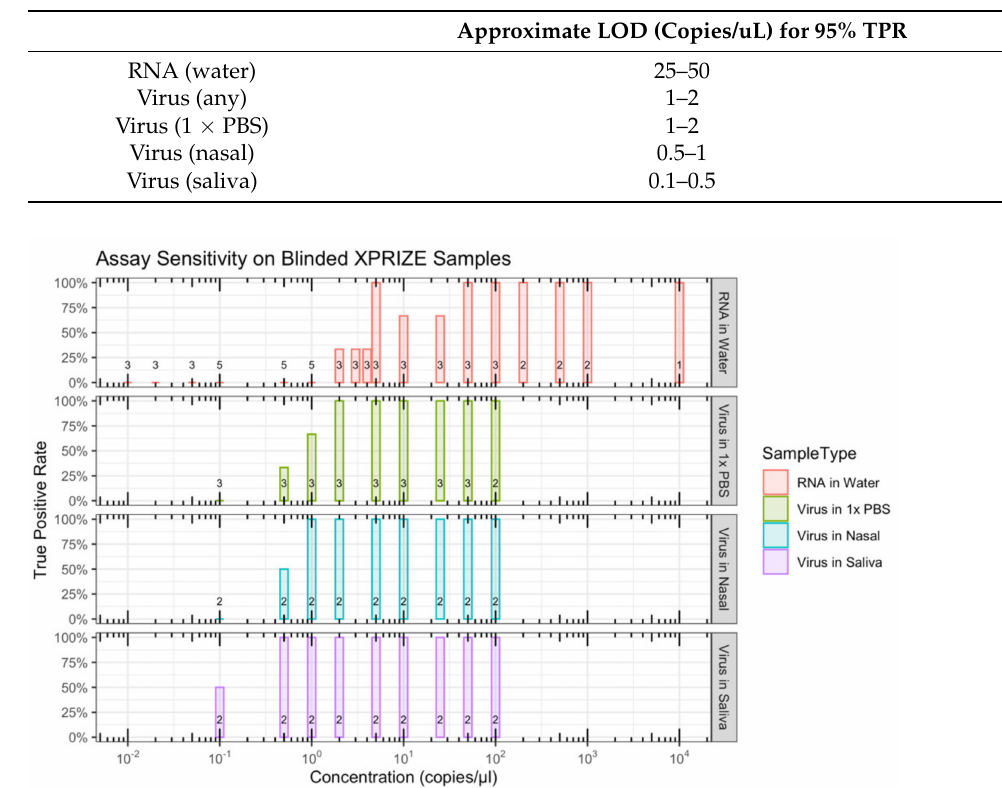
Table 1. Limits of detection (LOD) for a 95% true positive rate based on results from testing blinded XPRIZE samples.